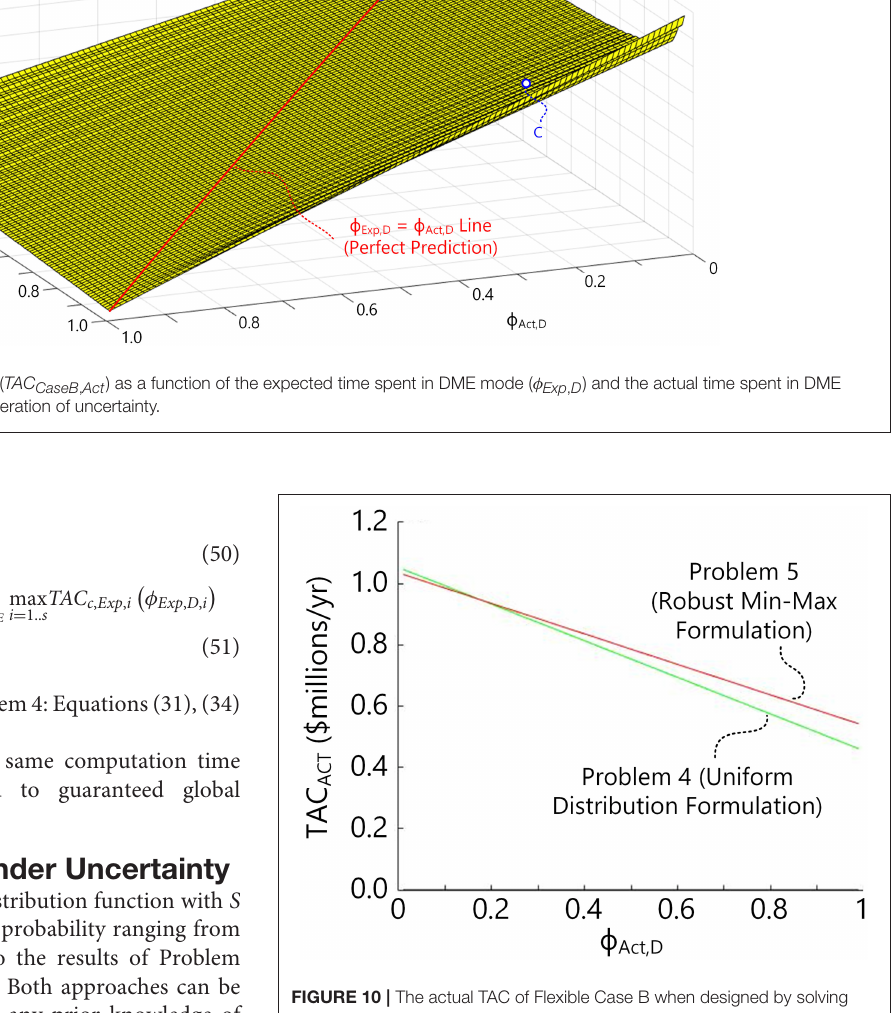
FIGURE 10 | The actual TAC of Flexible Case B when designed by solving Problem 4 with a uniform probability distribution and by solving Problem 5 (the robust min-max formulation), as a function of φ Act , D